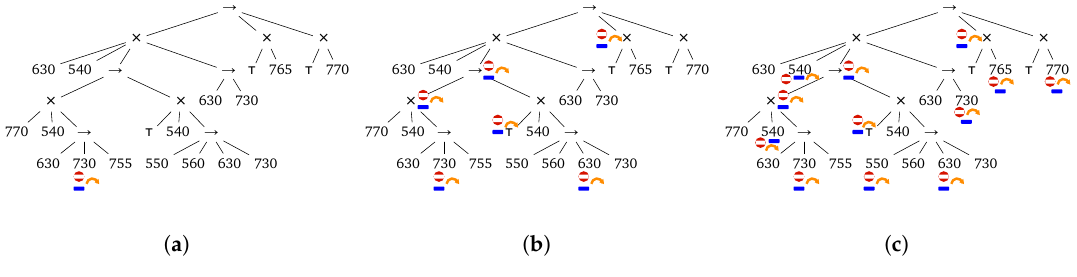
Figure 15. CPTs based on the model discovered by the ETM Approach 4. ( a ) CPT 4-A contains one configurable node; ( b ) CPT 4-B contains six configurable nodes; ( c ) CPT 4-C contains 12 configurable